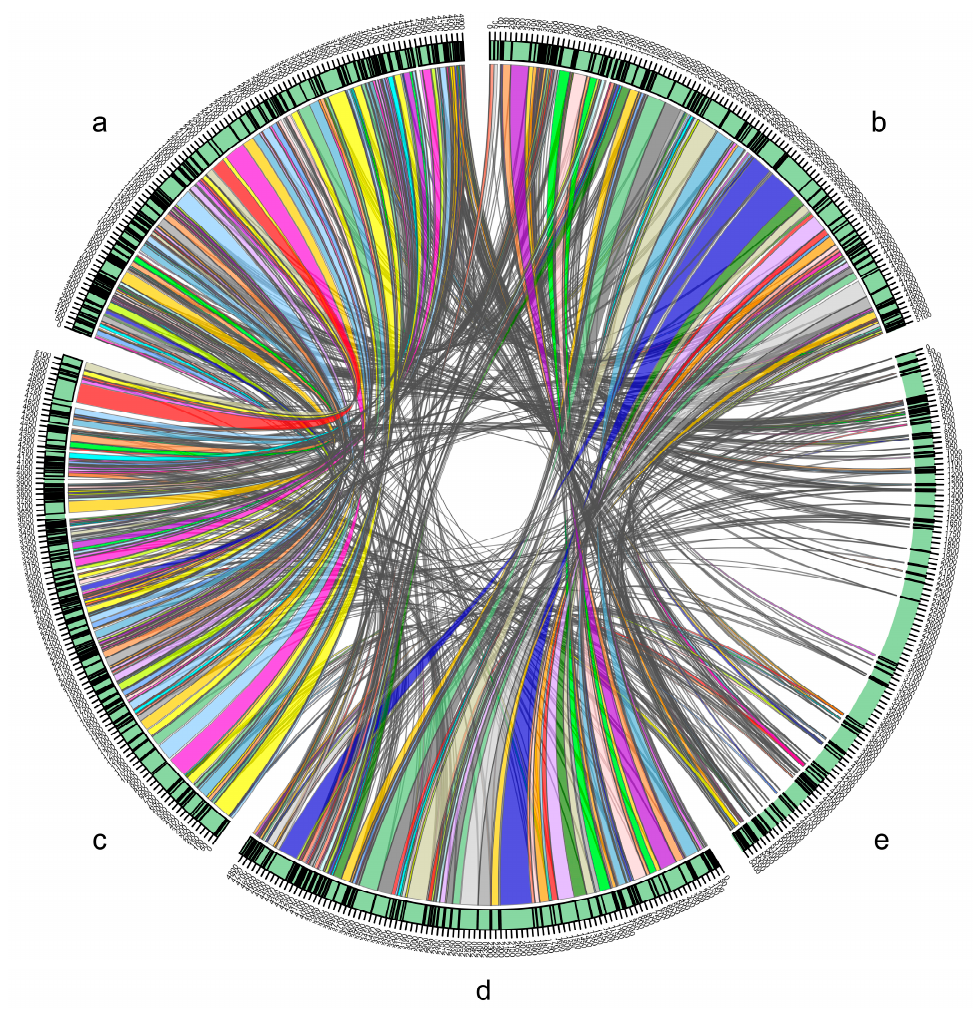
Figure 2. Genomic synteny shared between Kosakonia sacchari LMG 26783T ( a ), FY-07 ( b ), Kosakonia quasisacchari WCHEs120001T ( c ), Kosakonia oryzendophytica LMG 26432T ( d ) and Kosakonia oryzae LMG 24251T ( e